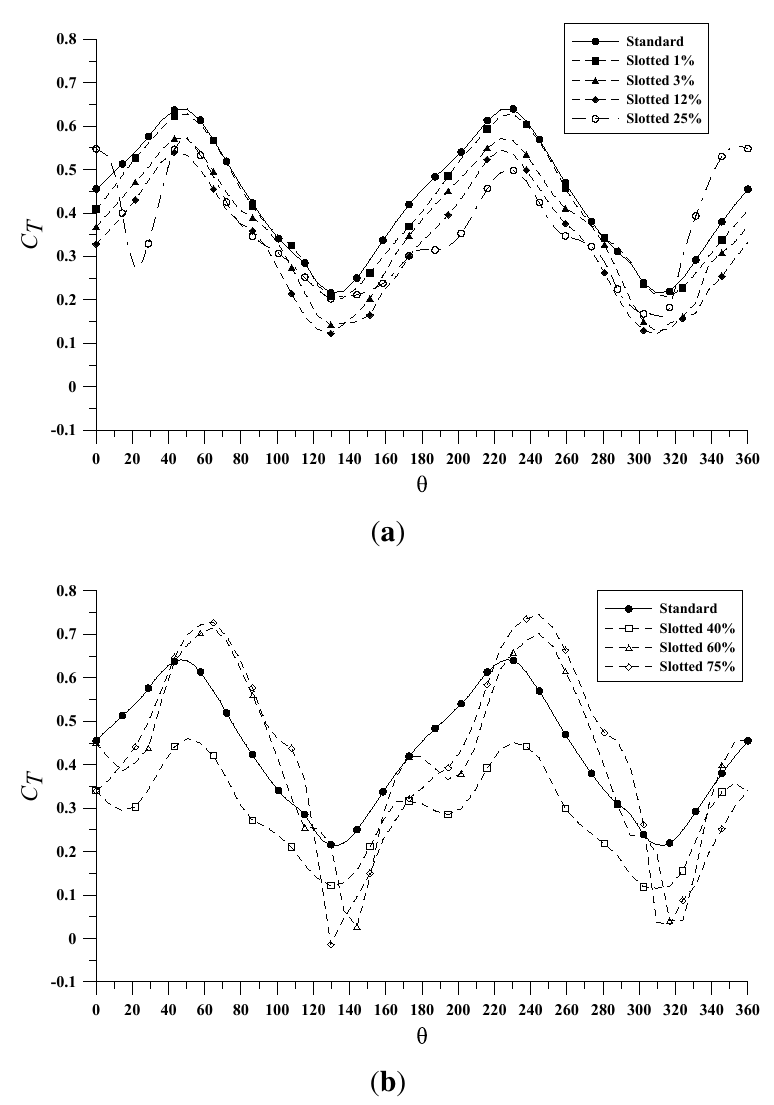
Figure 10. Dynamic torque coefficient vs blade angular position θ at λ = 1 for standard ( a ) f = 1% , f = 3% and f = 12% ; and for ( b ) f = 25% , f = 40% , f = 60% and f = 75%